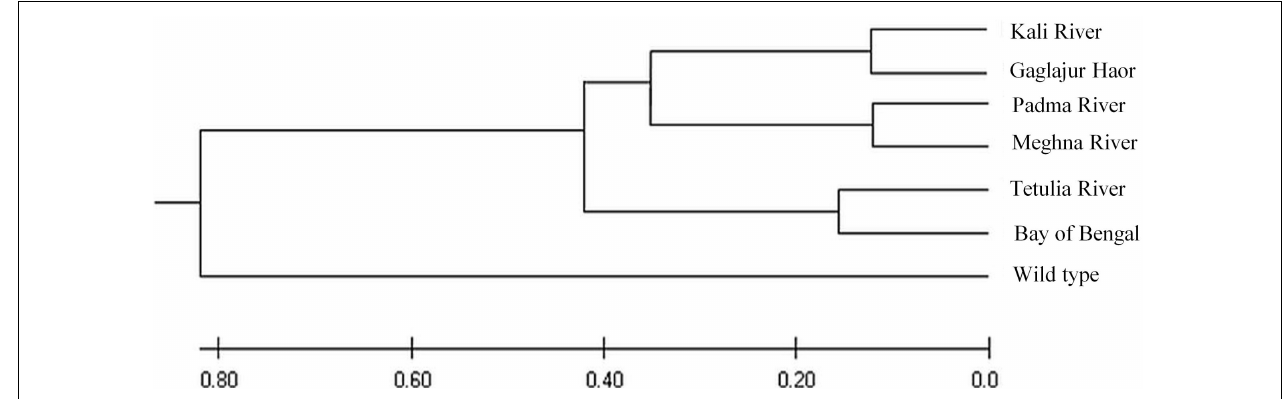
FIGURE 10 | Unrooted phylogenetic tree of T. ilisha produced by the UPGMA method based on mtDNACyt b